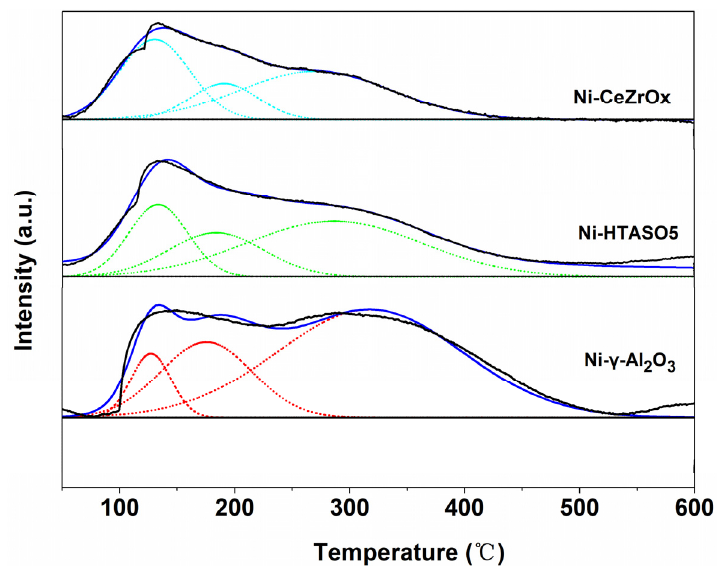
Figure 5. Temperature-programmed NH 3 desorption (NH 3 -TPD) profile of Ni- γ -Al 2 O 3 , Ni-HTASO5 and Ni-CeZrO x catalysts. Table 4. Acidity measured by temperature programmed NH 3 desorption experiment on Ni- γ -Al 2 O 3 , Ni-HTASO5 and Ni-CeZrO x catalysts and weight loss of catalysts determined by thermogravimetric analysis. Peak Catalysts